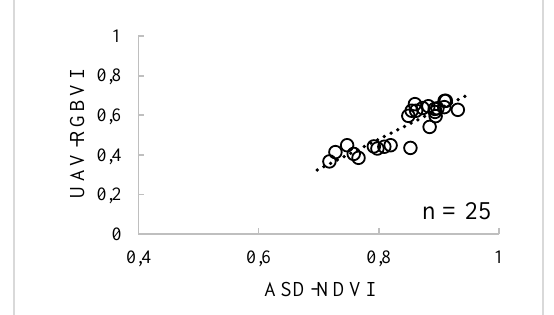
Figure 6. Regression of the UAV-based RGBVI and ASD Fieldspec3-based NDVI per plot for the second sampling date (16.04.2014, ASD & UAV).